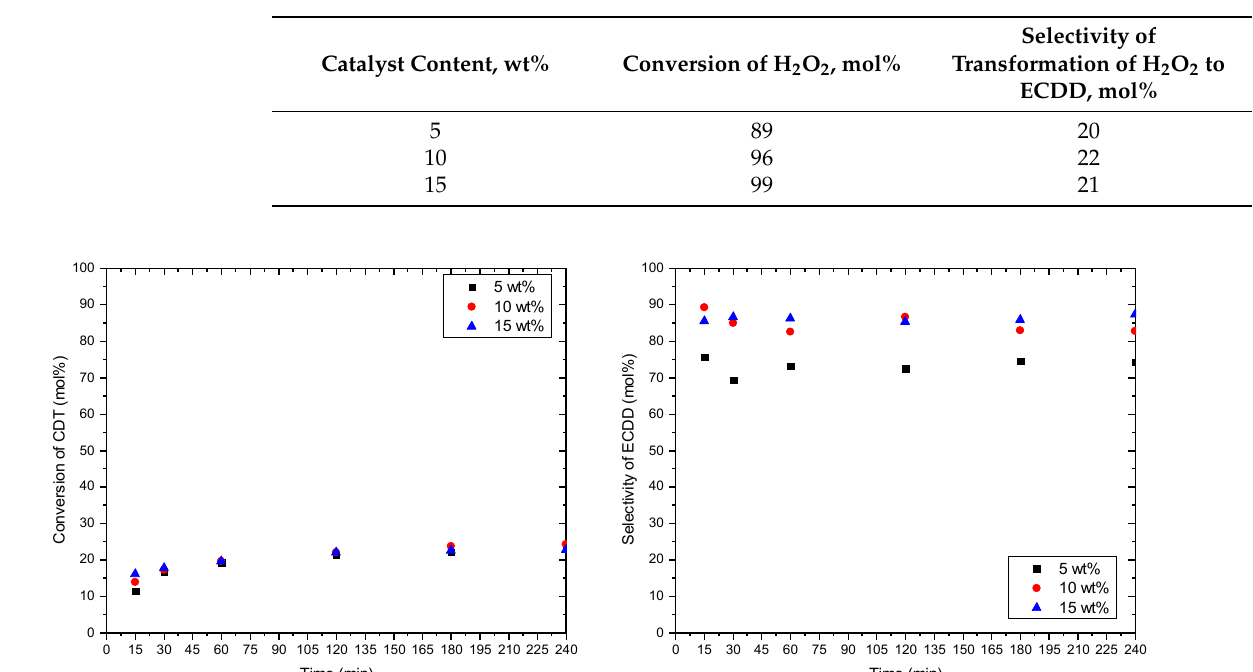
Table 5. Values of the conversion of H 2 O 2 and selectivity of transformation of H 2 O 2 to ECDD obtained after 4 h of performing the reaction with different catalyst contents. Reaction conditions were as given for Figure 15.